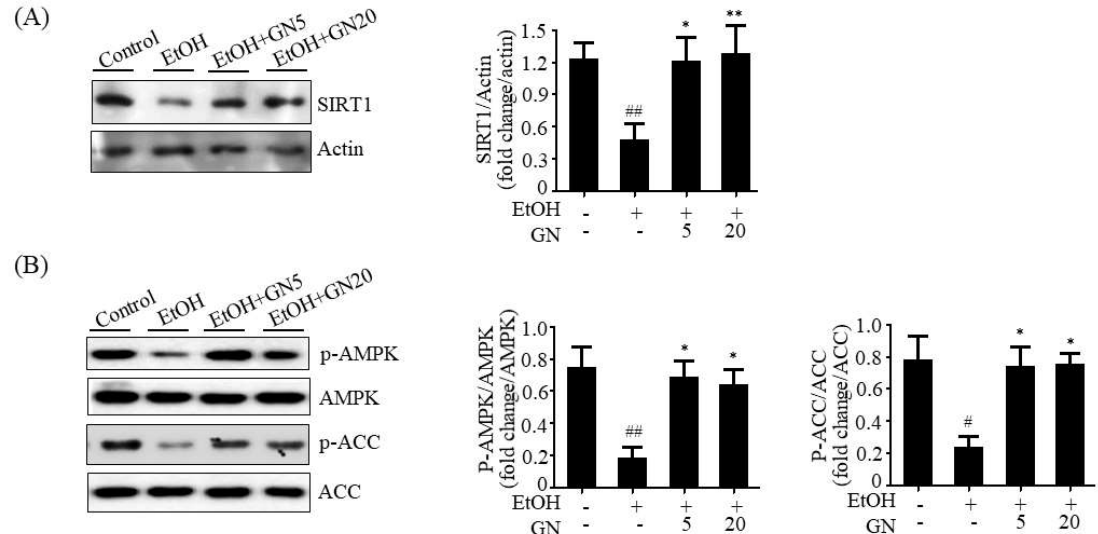
Figure 5. Gomisin N prevents ethanol-mediated reduction in sirtuin1 (SIRT1) and phosphorylated AMP-kinase (AMPK) in the liver of chronic-binge ethanol-fed mice. ( A ) Western blot analysis of SIRT1. Representative images are shown ( left ). SIRT1 level was quantified by densitometry ( right ). ( B ) Western blot analysis of p-AMPK and acetyl-CoA carboxylase (p-ACC). Representative images are shown ( left ). Levels of p-AMPK and p-ACC were quantified by densitometry ( right ). Values are the mean ± SD ( n = 6). # p < 0.01, ## p < 0.01 vs. pair-fed control mice, * p < 0.05, ** p < 0.01 vs. ethanol-fed mice.